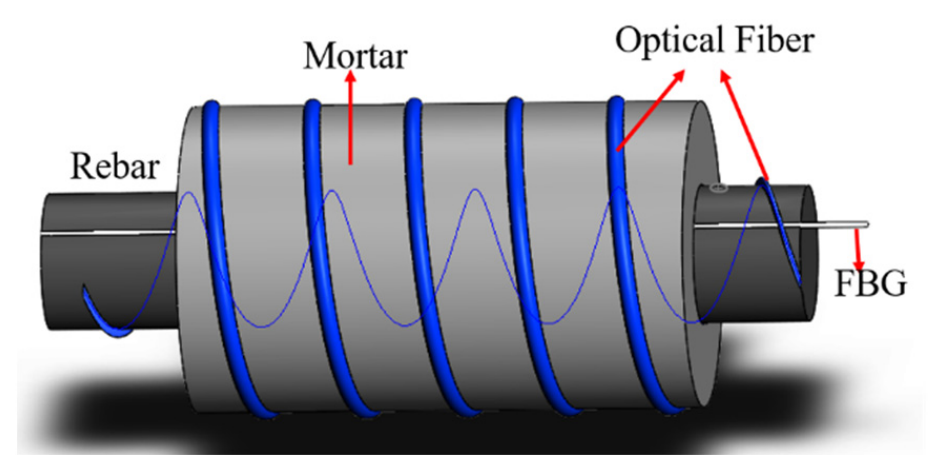
Figure 1. Basic structure of the spiral fiber sensor.